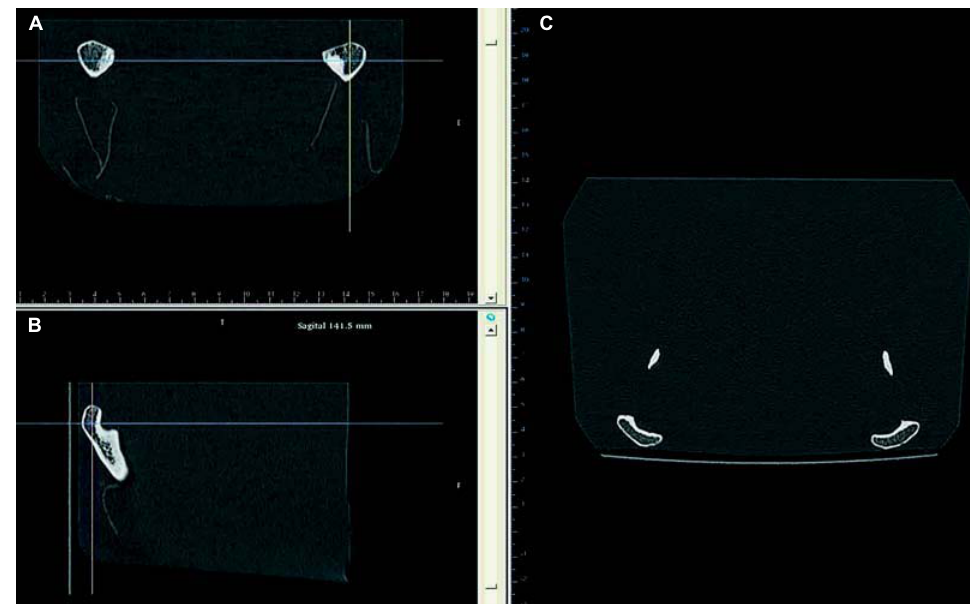
FIGURE 3- Multiplanar reconstructed (MPR) images: (A) axial, (B) coronal, and (C) sagittal, in bone window